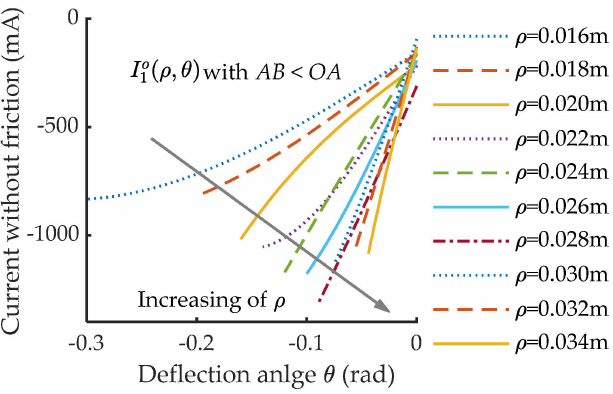
Figure 19. Frictionless current estimation for cam C 1 in configuration II.